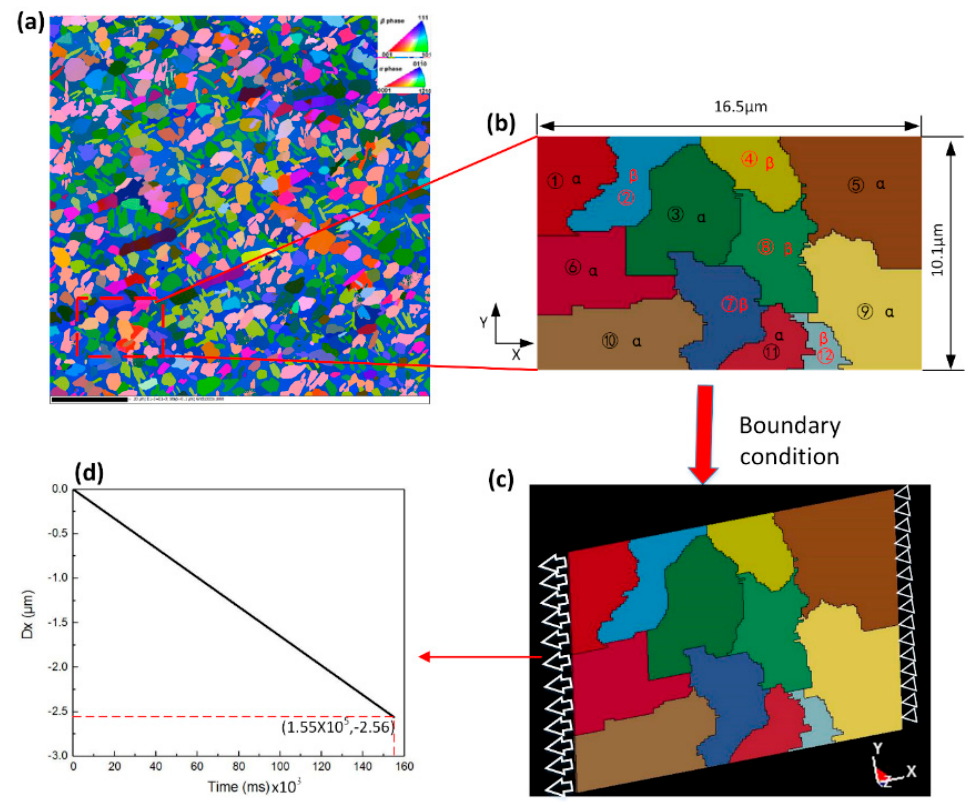
Figure 2. Process of developing the crystal plasticity finite element simulation method (CPFEM): ( a ) the Electron Backscatter Diffraction (EBSD) inverse pole figure (IPF) mapping, ( b ) 2.5D finite element model, ( c ) boundary condition, ( d ) displacement-time curve.